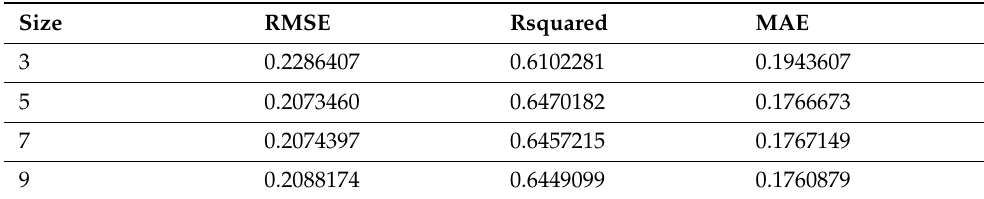
Table 5. Errors values for different number of neurons in hidden layer of MLP with hyperbolic tangent activation function.